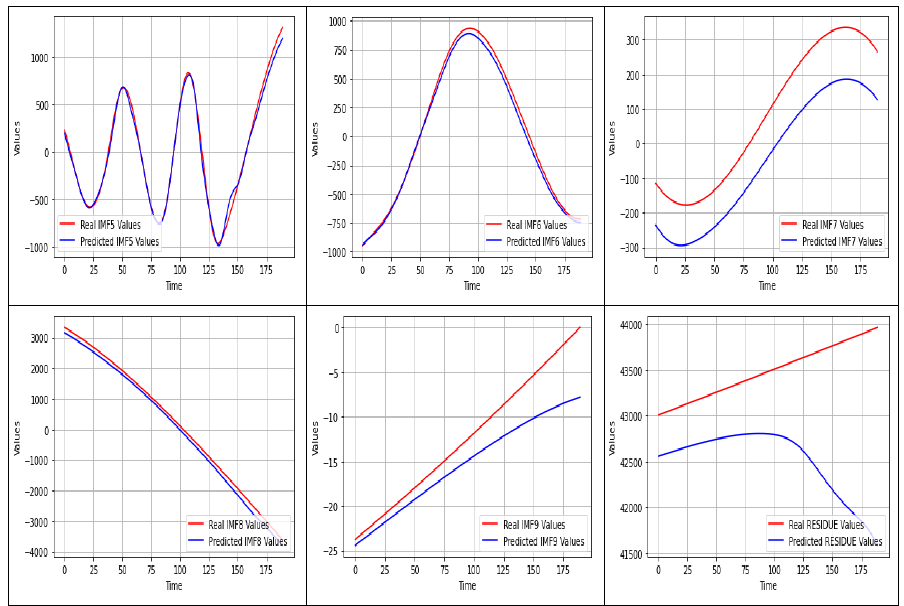
Figure 6. Predicted results of correlated subcomponents obtained from the EMD-LSTM model. Appl. Sci. 2023 , 13 , x FOR PEER REVIEW